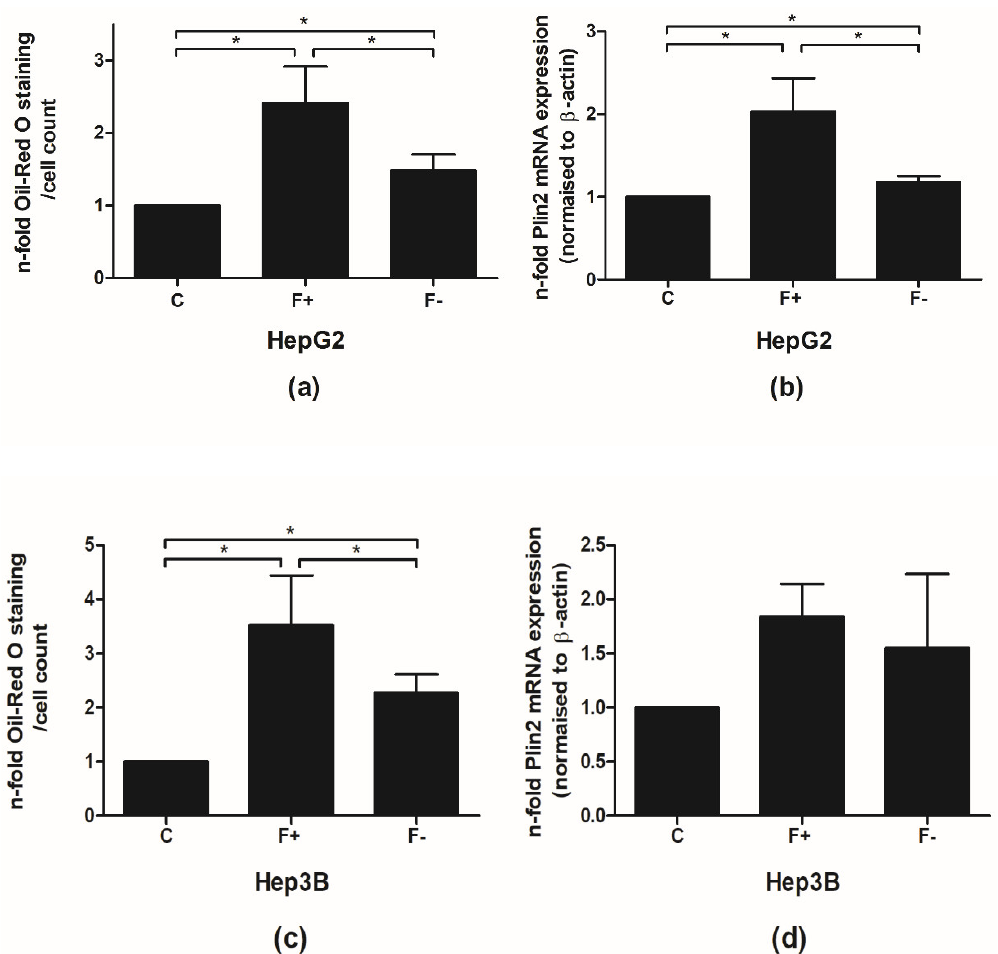
Figure 2. Cultivation with palmitic and oleic acid induces fat accumulation in hepatic cell lines. HepG2 and Hep3B cells were cultured with control medium (C) or medium supplemented with a mixture of palmitic and oleic acid (PA/OA medium) for 96 h to induce fat accumulation. Afterward, cells were treated with a control medium to induce diminution of intracellular fat accumulation (F- ) or continually with PA/OA medium (F+), mimicking the situation before bariatric surgery. Oil-Red-O staining ( a , c ) and expression of Plin2 mRNA ( b , d ) of HepG2 and Hep3B cells are shown. The figure depicts the mean values of five independent experiments performed in duplicates ± S.D. * p -values < 0.05.